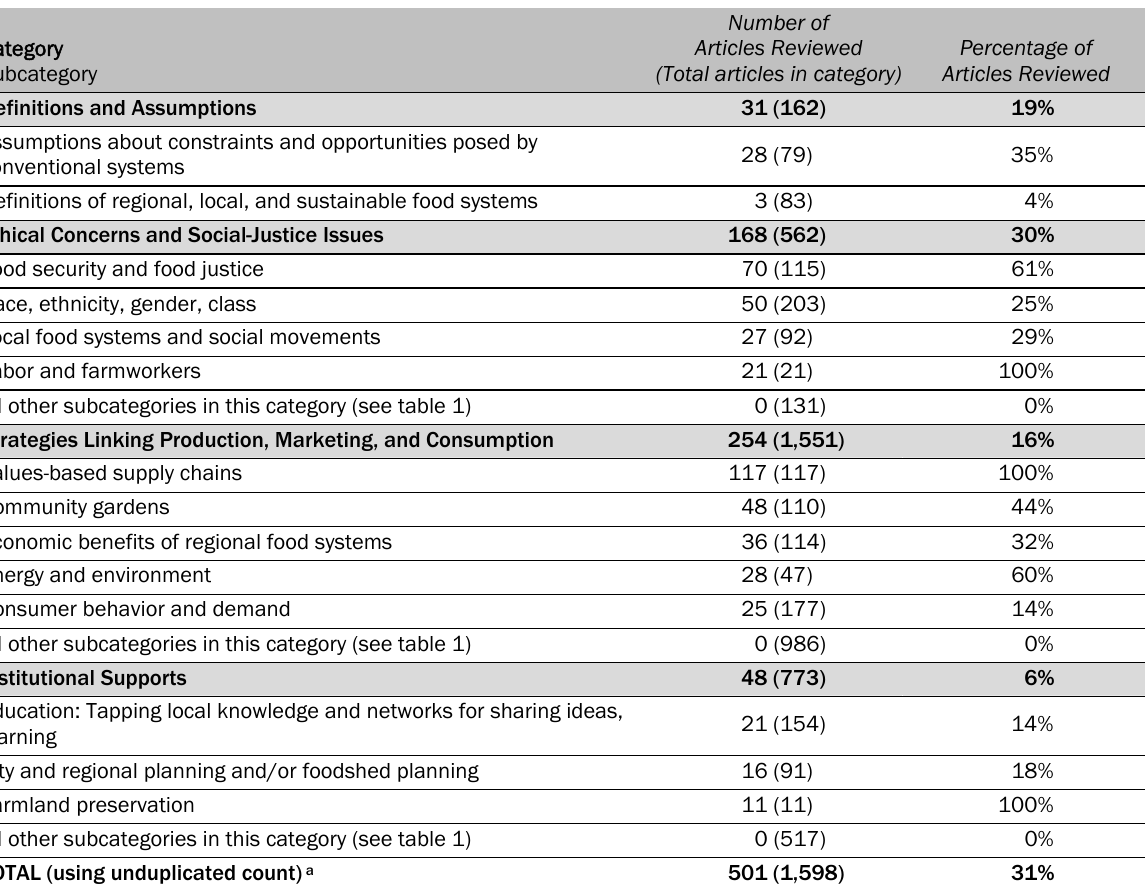
Table 2. Count and Percentage of Articles Reviewed Within Each Category and Subcategory (out of all articles in the